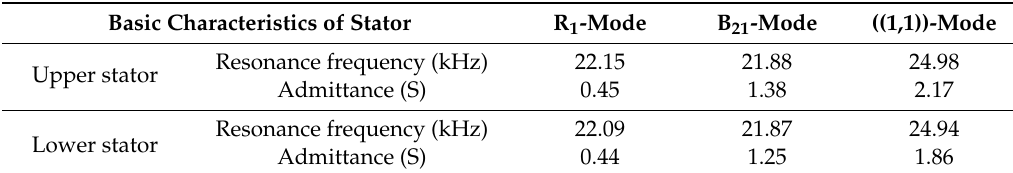
Figure 14. Photograph of assembled prototype of the sandwich-type MDOF-SUSM.